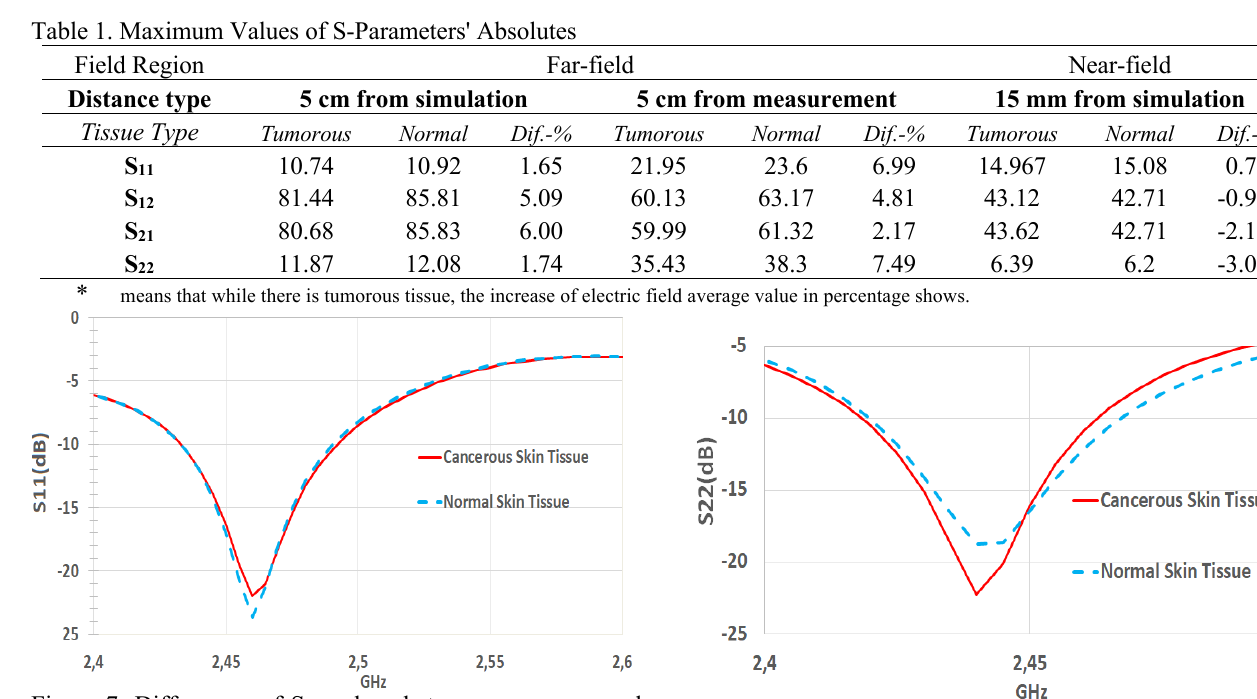
Figure 7: Differences of S 11 values between cancerous and normal tissue obtained from the experimental setup